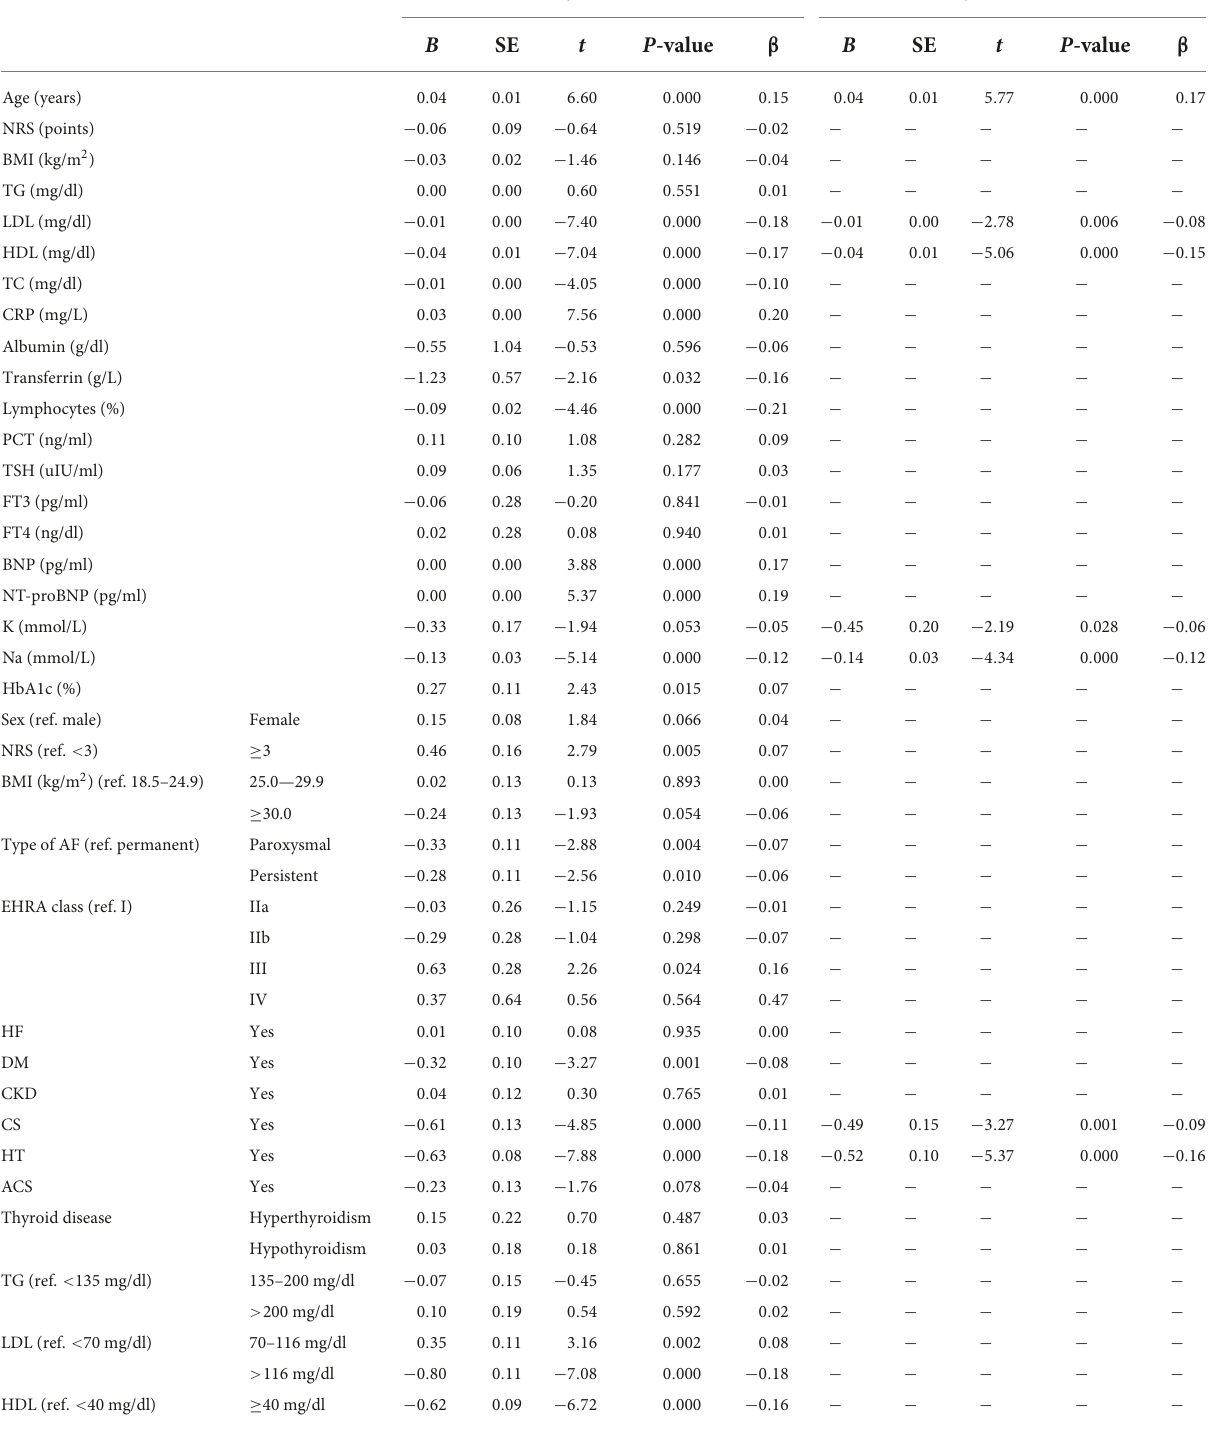
TABLE 5 Effect of selected parameters on length of hospital stay (days) (univariate model and multivariate predictors included in the linear regression analysis). Parameter Unadjusted model Adjusted model B SE